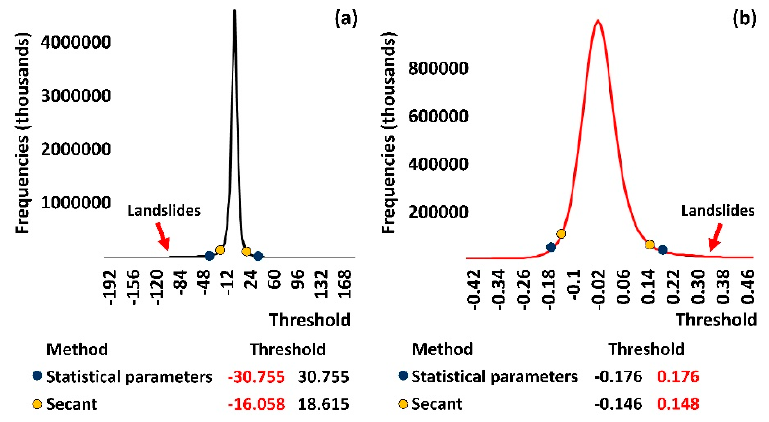
Figure 10. Frequency histograms of change images ( a ) LR-PC1, and ( b ) LR-NDVI.